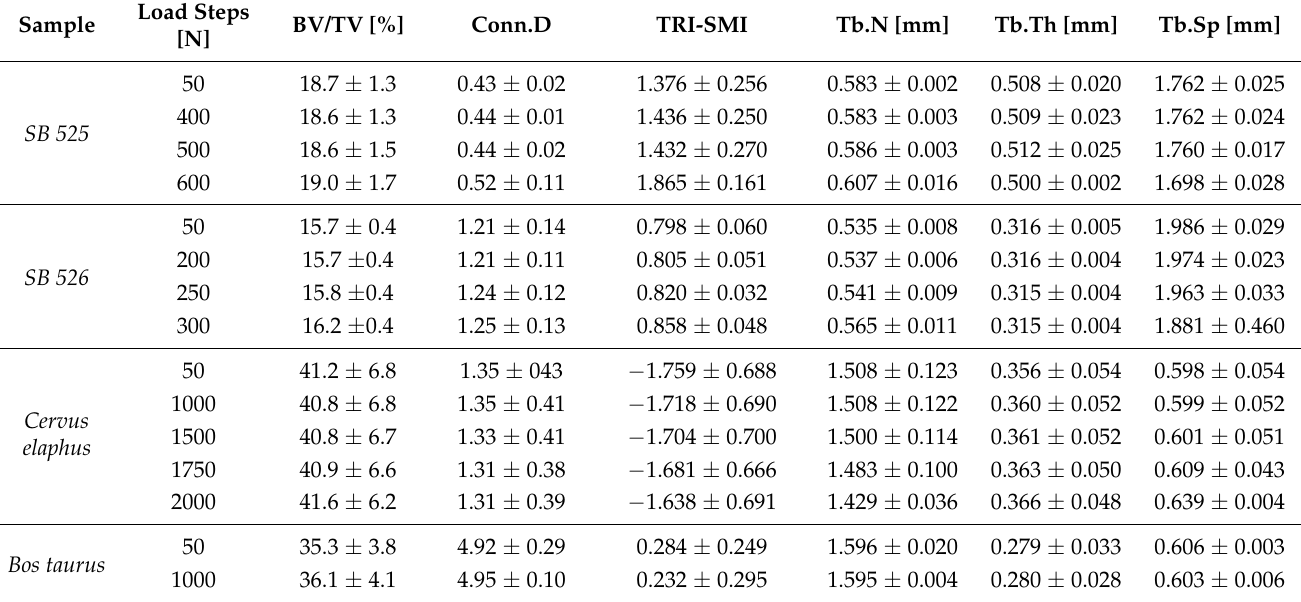
Table 4. Structure parameters of Bos taurus , Cervus elaphus and Sawbones Samples in